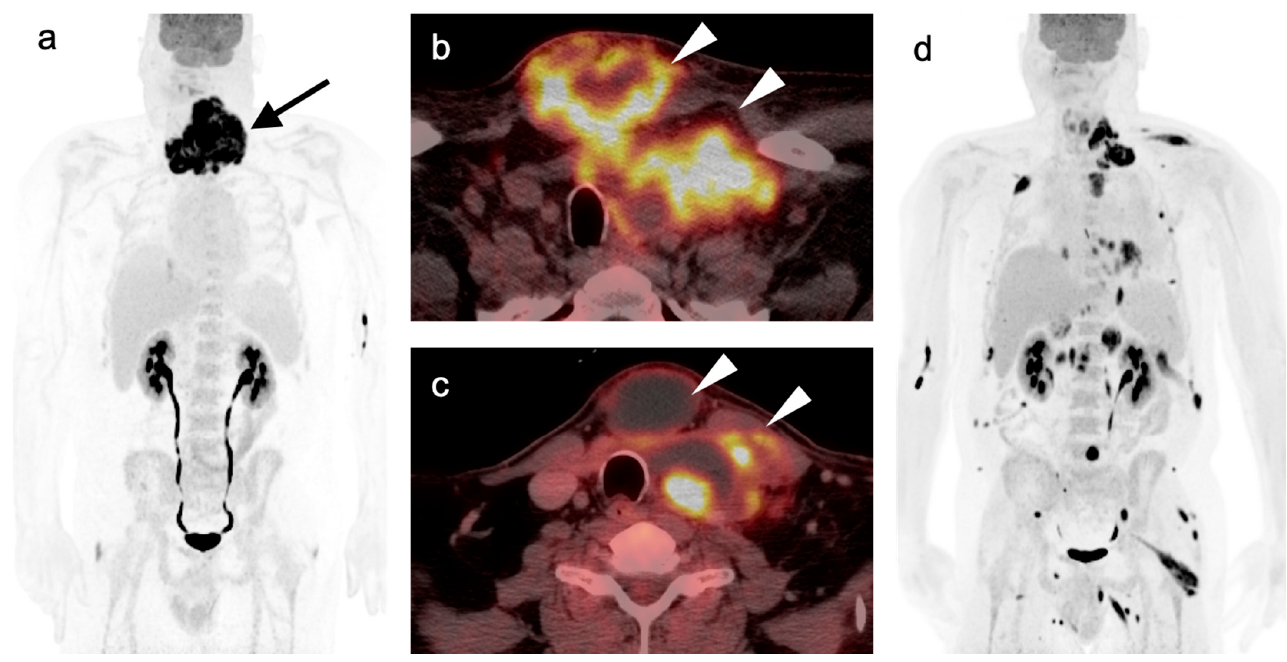
Figure 32. Anaplastic thyroid cancer. ( a , b ) At initial diagnosis, tumor is localized to the lower neck, as shown by ( a ) FDG PET MIP (black arrow) and ( b ) FDG PET ‐ CT axial image (white arrow); 6 months later ( c , d ), after treatment for anaplastic thyroid cancer, the primary tumor has become smaller and partially cystic (( c ), white arrows) but portions remain metabolically active. However, there is now widespread metastatic disease as shown by FDG PET MIP ( d ).